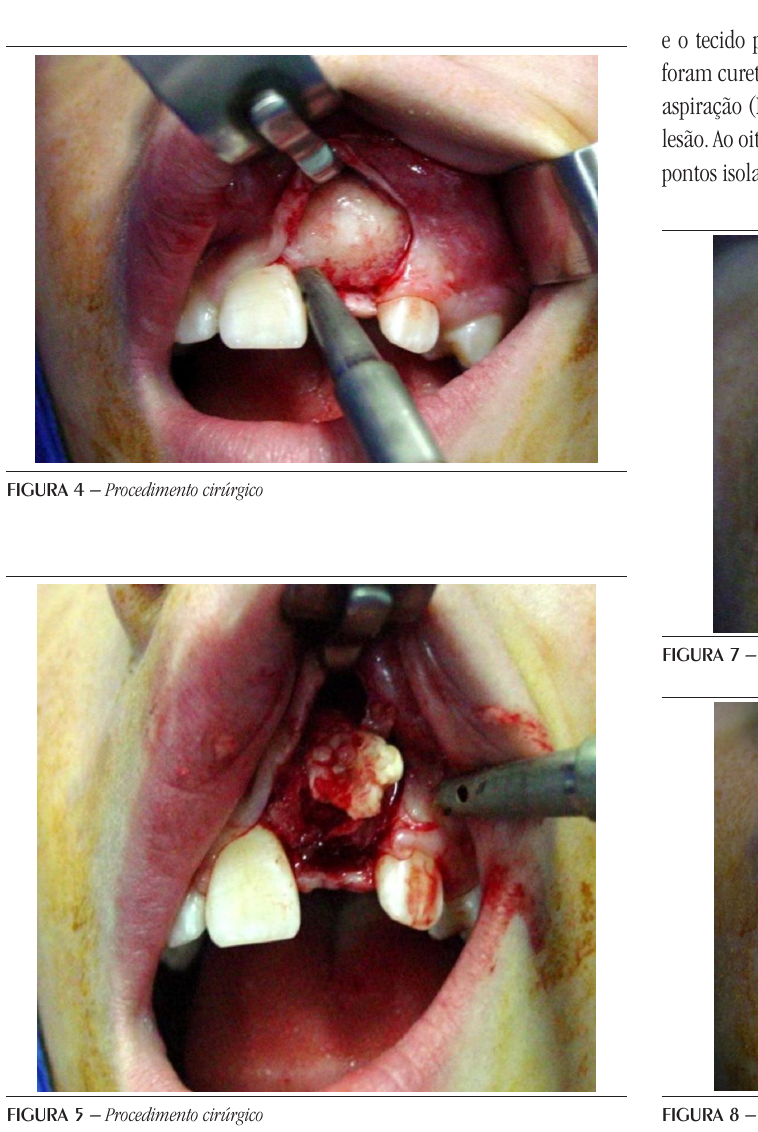
FIGURA 6 – Procedimento cirúrgico